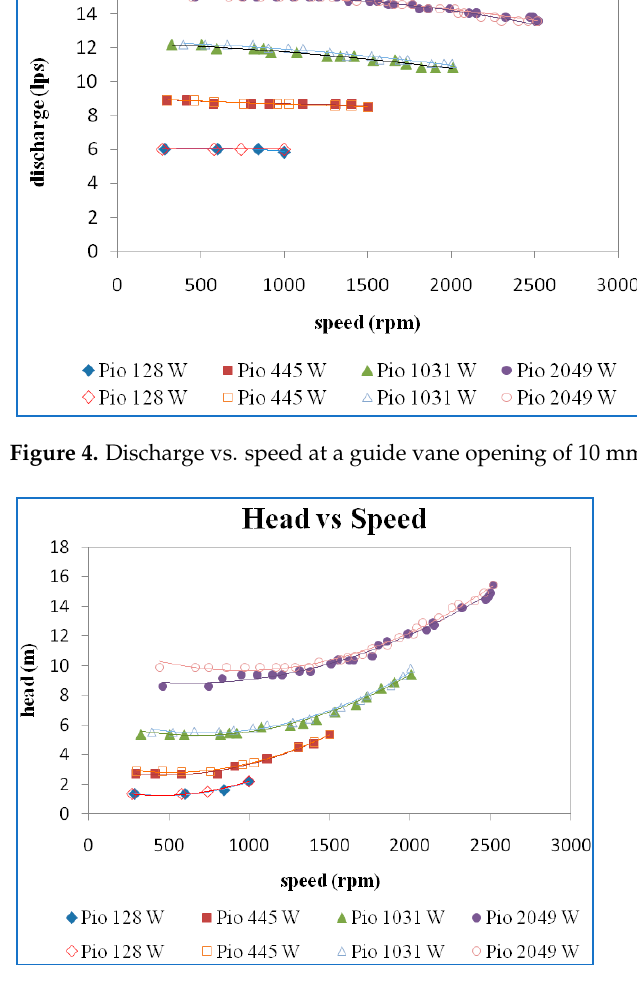
Figure 5. Head vs. speed at a guide vane opening of 10 mm.